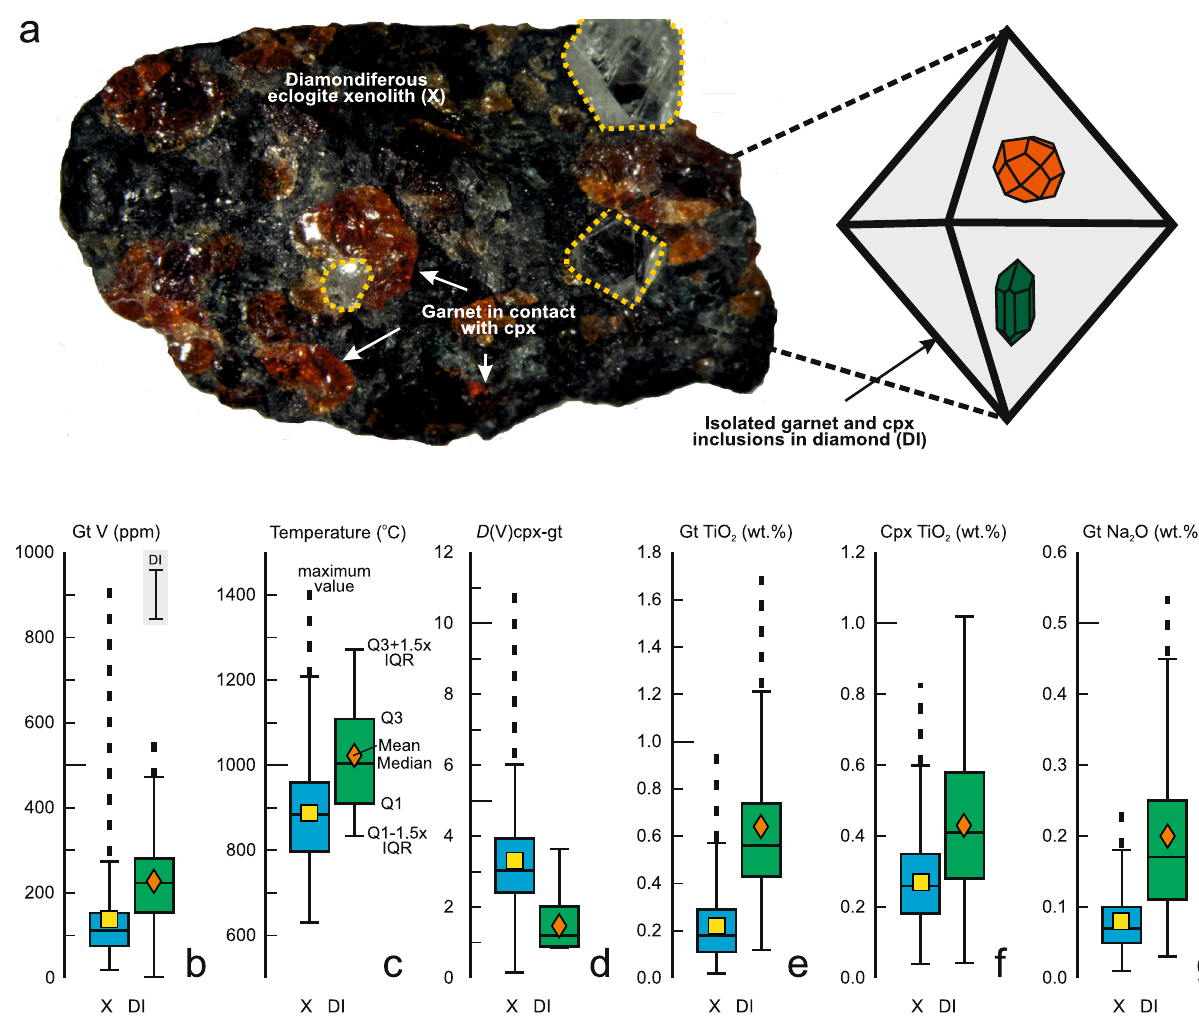
Fig. 1 Illustration of the closed-system behaviour of isolated eclogitic inclusions in diamond (DI) vs. open-system behaviour of touching inclusions in eclogite xenoliths (X). a Photograph of a diamondiferous eclogite xenolith from Fort à la Corne (~1.5 cm longest dimension); diamond crystals are highlighted in yellow stipples. Also shown is the schematic of a diamond hosting eclogitic garnet and clinopyroxene inclusions that are non-touching, which prevents them from chemically re-equilibrating to lower temperatures, while the inert diamond also protects them from communicating with the open- system matrix. Contrasting temperature estimates and compositions shown as box-and-whisker plots: b Vanadium concentrations (ppm) in garnet (gt), c temperature estimates (°C) re fl ecting those of the eclogite sources at the time of xenolith entrainment in kimberlite, vs. the time of encapsulation of non- touching inclusions in diamond, d Distribution ( D ) of V between clinopyroxene (cpx) and garnet ( D (V) cpx-gt ), e TiO 2 content (wt.%) in garnet, f TiO 2 content (wt.%) in clinopyroxene, g Na 2 O content (wt.%) in garnet. Explanations for the statistical parameters displayed in this fi gure (mean, median, Q1 fi rst quartile, Q3 third quartile) are shown in panel c . The whiskers are here de fi ned as Q3 + 1.5×IQR (interquartile range), and Q1-1.5×IQR or the minimum value, whichever is higher; stippled lines extend to the maximum value if >Q3 + 1.5×IQR. Average 1 σ uncertainty on V abundances in garnet from DI of 117 ppm is shown as error bar; average 1 σ uncertainty on V abundances in garnet from xenoliths of 5.6 ppm is not displayed at the scale; both correspond to typical uncertainties for multiple analyses per sample reported in the literature, see Methods). Data sources in Supplementary Data